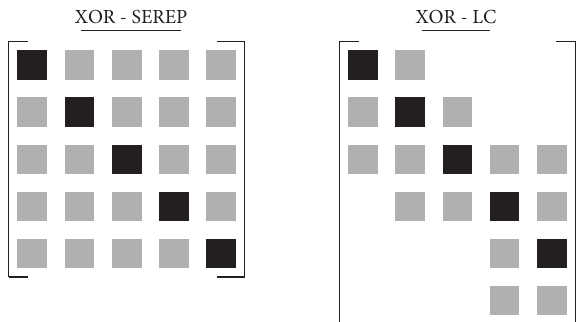
Figure 1: Theoretical illustration of the XOR matrix for two well-correlated models using SEREP (a) and LC (b). Black elements illustrate values close to 1, and grey elements illustrate values close to 0.